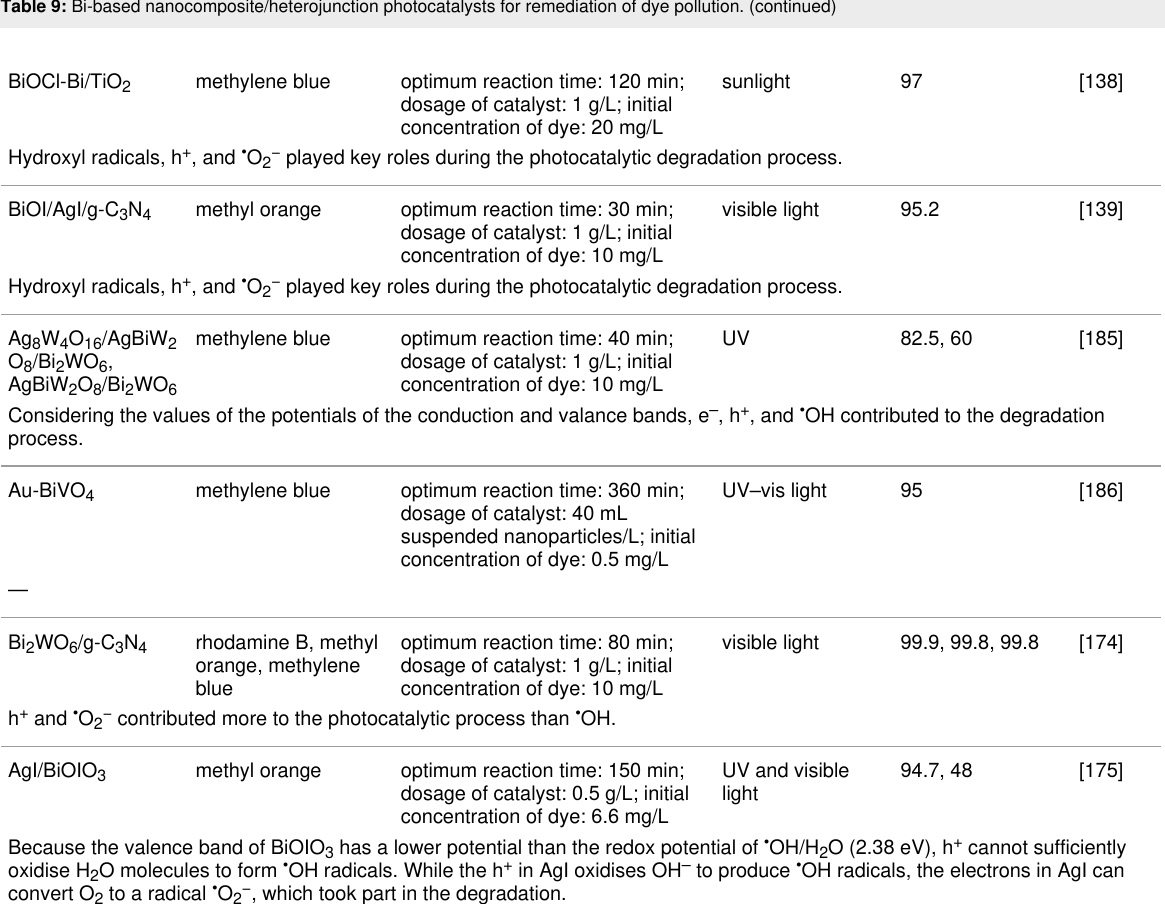
Table 9: Bi-based nanocomposite/heterojunction photocatalysts for remediation of dye pollution. (continued)